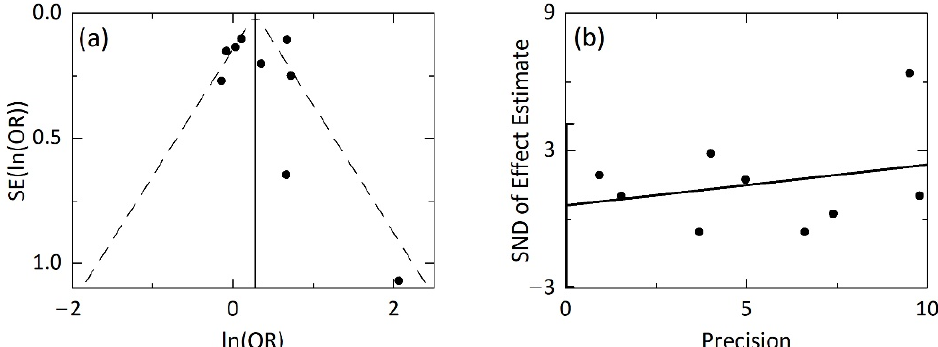
Figure 3. Publication bias in the whole studies ( n = 9). ( a ) Funnel plot of (ln(OR i ), SE(ln(OR i ))) [denoted by solid circles( • )] for individual studies ( i = 1, . . . , 9). Vertical solid line passes the pooled ln(OR) (=0.277). Left and right dashed lines represents the 95% pseudo confidence limits. ( b ) Egger’s test for asymmetry of the funnel plot. Solid circles represent (Precision, SND) for individual studies; SND = ln ( OR ) /SE ( ln ( OR )) and Precision = 1/SE ( ln ( OR )) . A solid linear regression line is shown, and the vertical line on the SND axis represents the 95% CI for the intercept. Abbreviations: OR, odds ratio; CI, confidence interval; SE, standard error; SND, standard normal deviate.